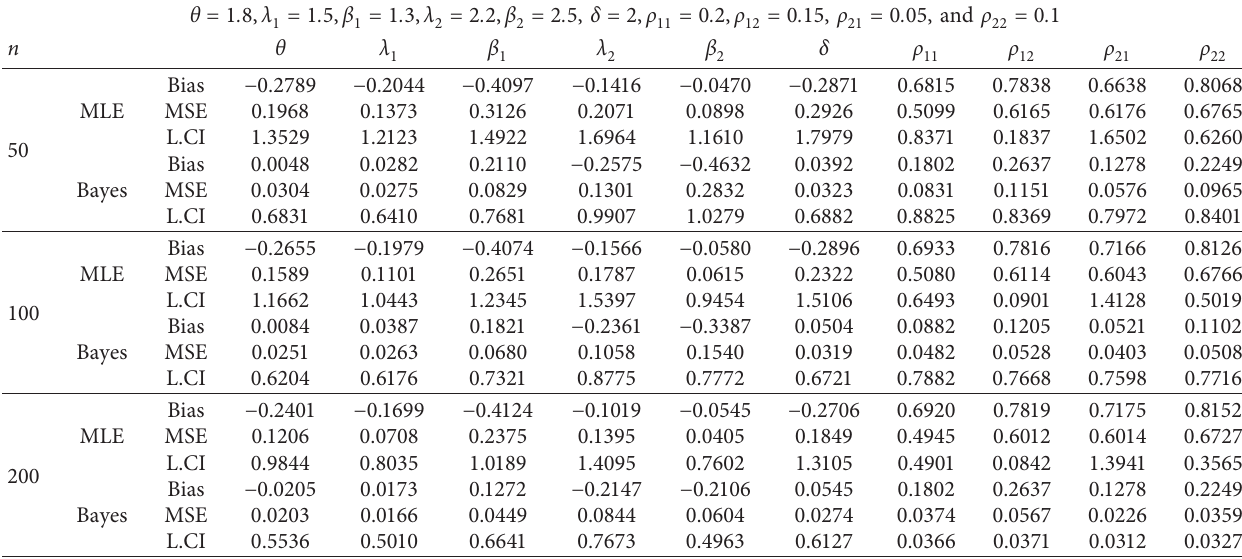
Table 5: MLE and Bayesian estimation with different sample sizes in dependent case (Case III).